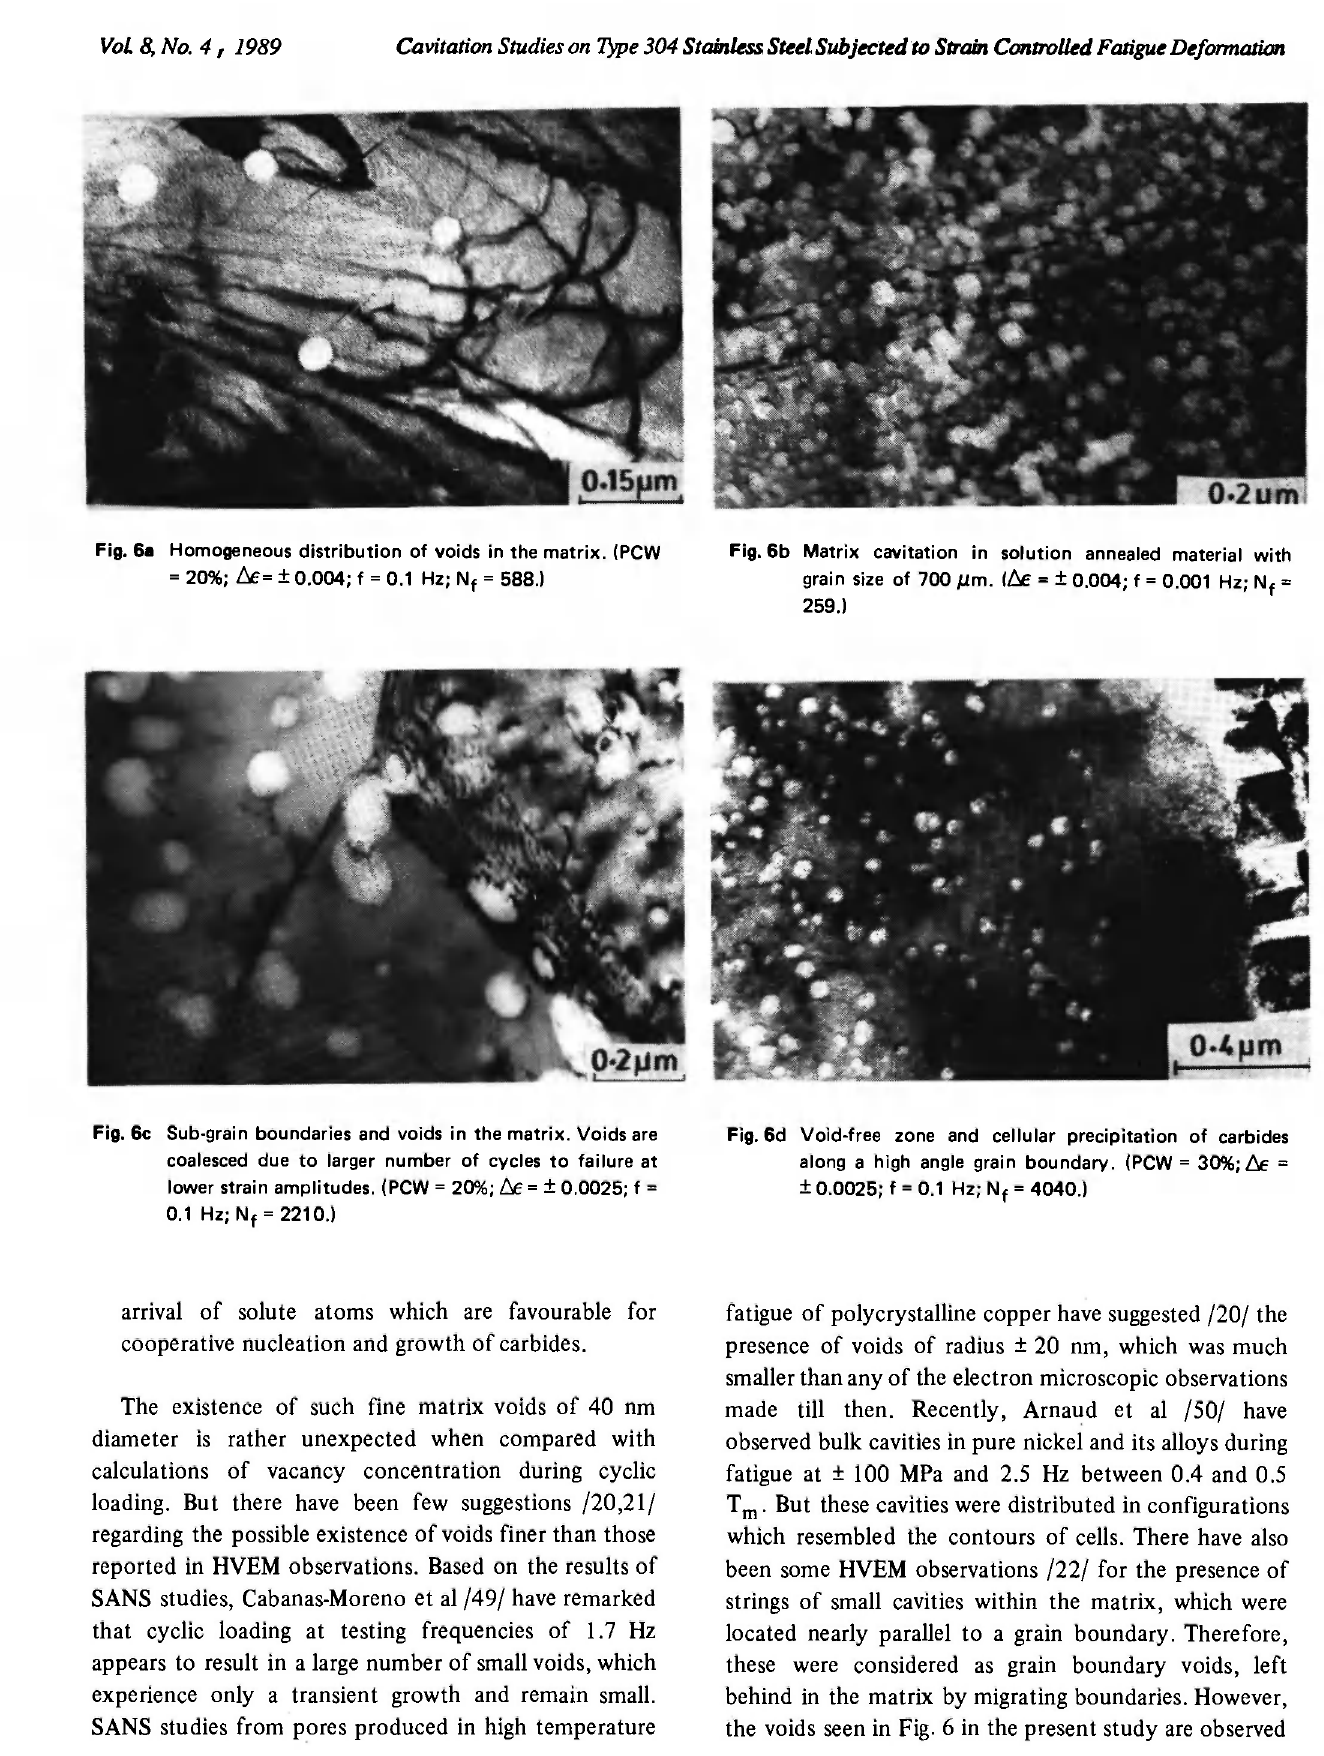
Fig. 6a Homogeneous distribution of voids in the matrix. (PCW